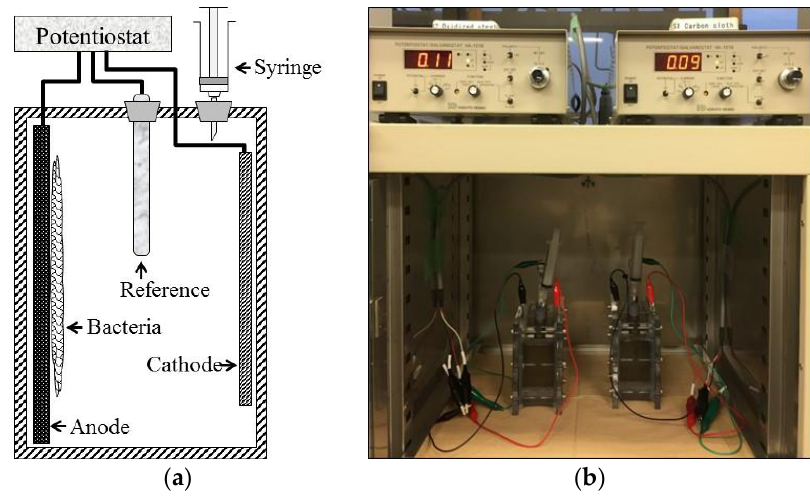
Figure 1. ( a ) Schematic representation and ( b ) photograph of the BES-based BOD biosensor used in this